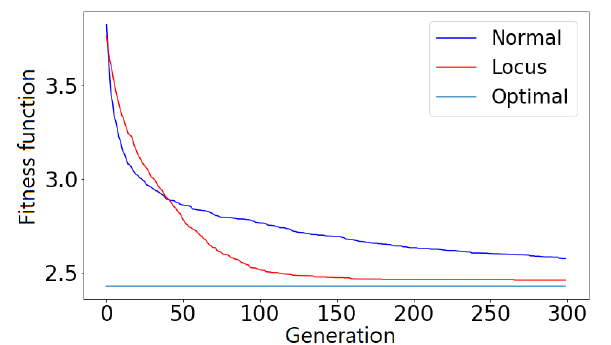
Figure 10. This Figure depicts TSP Problem with 10 cities manifesting the ability of our approach to surpass the traditional approach consuming the same time. We did run the the traditional approach for two times more generations e.g., when axis x equals 25 generations for locus mutation (as in the figure), it equals 25 * 2 generations for traditional mutation. All the experiments have been conducted with 200 population size and 0.5 mutation rate. We run the traditional approach for 600 generations, while we run locus mutation only for 300 generations. The optimal solution has been obtained using brute force algorithm and the experiments were repeated 100 times. Table 4. Time comparison between locus and baseline mutation where PN is the number of cites, PS is population size, GN is the number of generations and MR is mutation rate. TSP timing gives us the time consumption for each algorithm using the specified parameters. Ratio gives us the speed rate, speed advantage, of the original